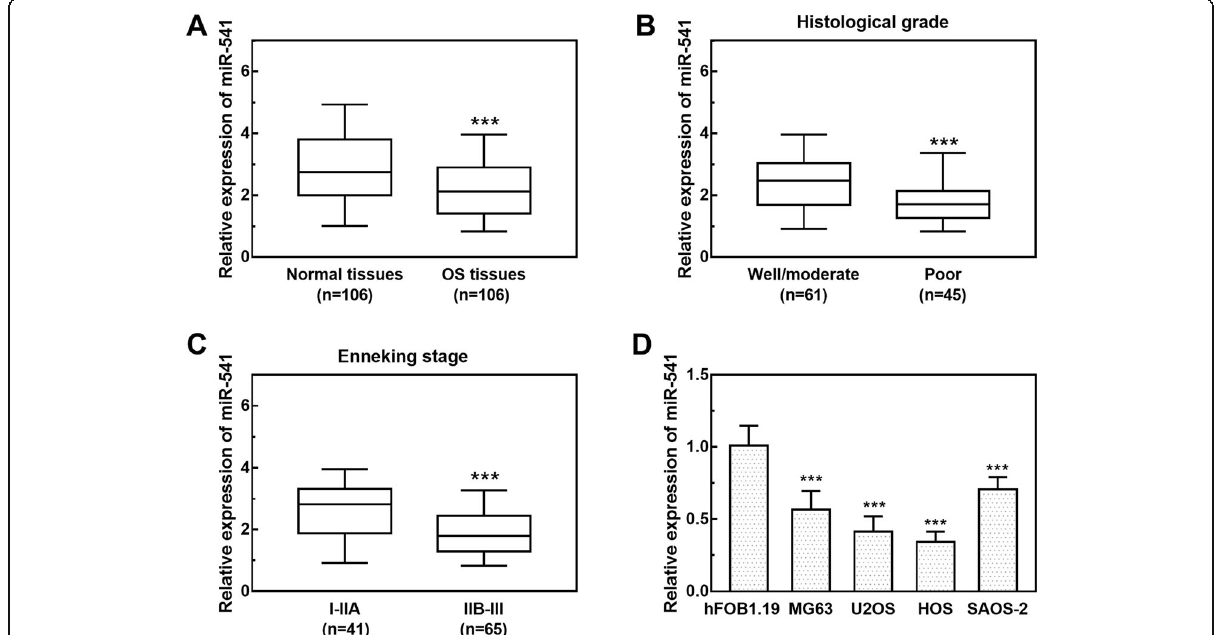
Fig. 1 miR-541 was downregulated in human OS tissues and cell lines. a The expression of miR-541 was significantly decreased in OS tissues compared with adjacent normal tissues (*** P < 0.001). b The expression of miR-541 was reduced in patients with poor differentiation (*** P < 0.001). c The expression of miR-541 was downregulated in patients with advanced Enneking stage compared with those with early stage (*** P < 0.001). (D) The expression of miR-541 was significantly decreased in OS cell lines compared with normal cells (*** P <